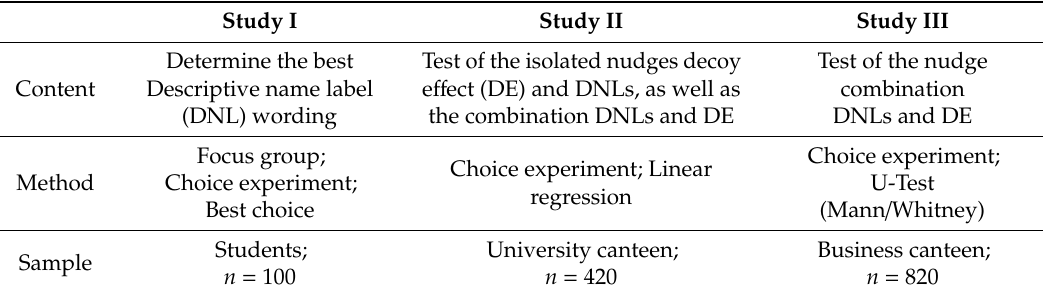
Table 1. Overview of the three studies.